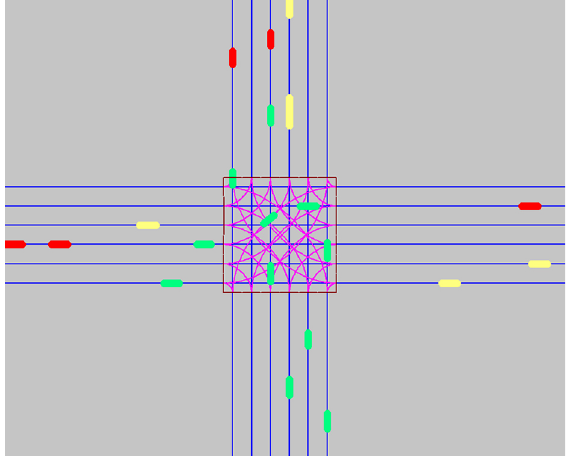
Fig. 3. Modelled ACUTA in